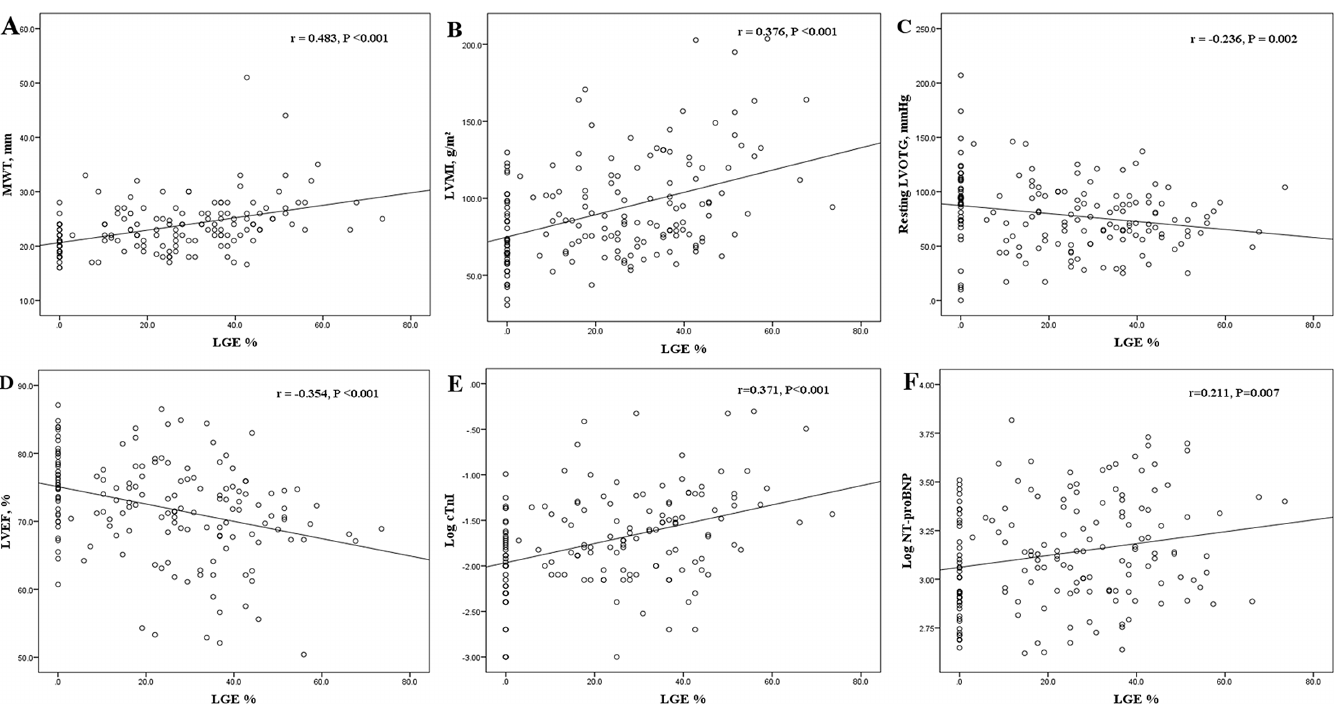
Fig 2. Correlations between the extent of LGE (LGE%) and MWT (A), LVMI (B), resting LVOTG (C), LVEF (D), Log cTnI (E) and log NT-proBNP (F) in the overall study patients. cTnI indicates cardiac troponin I; LVEF, left ventricular ejection fraction; LVMI, left ventricular mass index; LVOTG, left ventricular outflow tract gradient; MWT, maximum wall thickness; NT-proBNP, N-terminal pro B-type natriuretic peptide. Other abbreviations as in Fig